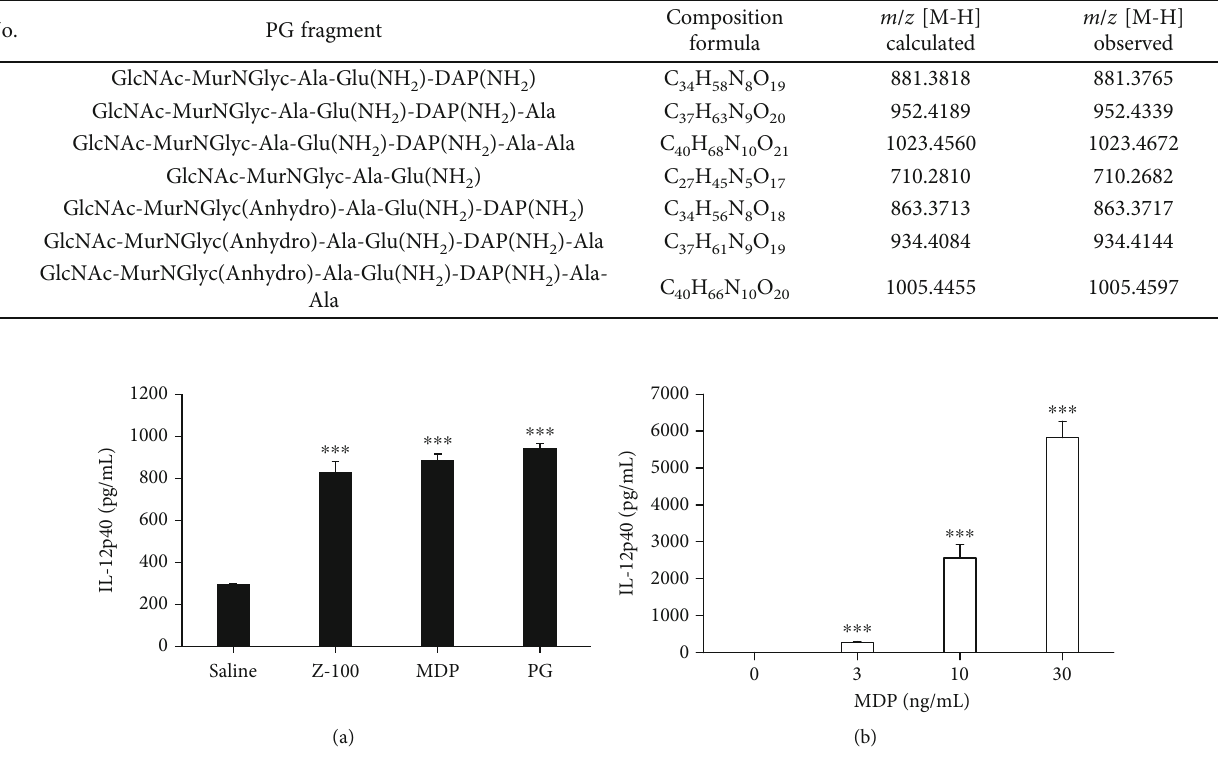
Figure 4: IL-12p40 production after stimulation with MDP and PG. (a) IL-12p40 concentration in the culture supernatant of BMDM after stimulation for 24 hours with Z-100 (100 μ g/mL), MDP (100ng/mL), or PG (2 μ g/mL). Data show the mean ± S : E : ; n = 16 per group, pooled from 4 experiments. (b) IL-12p40 concentration in the culture supernatant of human CD14 + cells after stimulation for 24 hours with MDP (3, 10, or 30ng/mL). Data show the mean ± S : E : ; n = 10 -12 per group, pooled from 3 experiments. Symbols indicate a signi fi cant di ff erence compared with the saline or 0 ng/mL group; ∗∗∗ P < 0 : 001 (Steel ’ s multiple comparisons